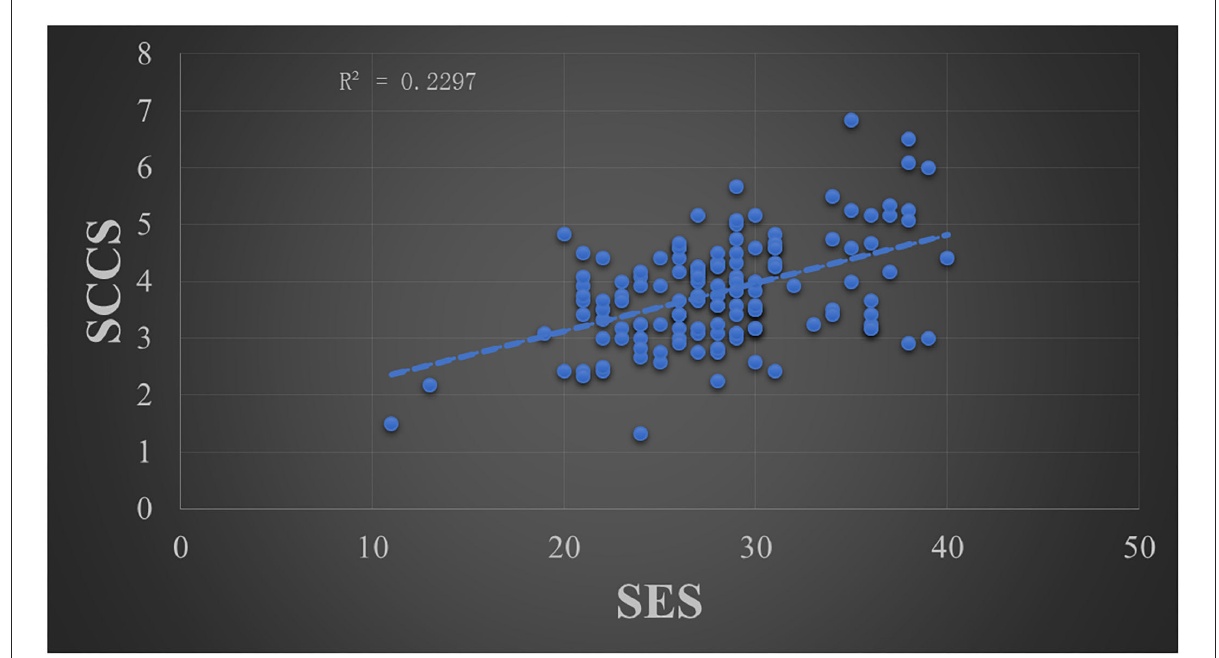
FIGURE1 The relationship between the mean score of the SCCS and the total score of the Rosenberg self-esteem scale.